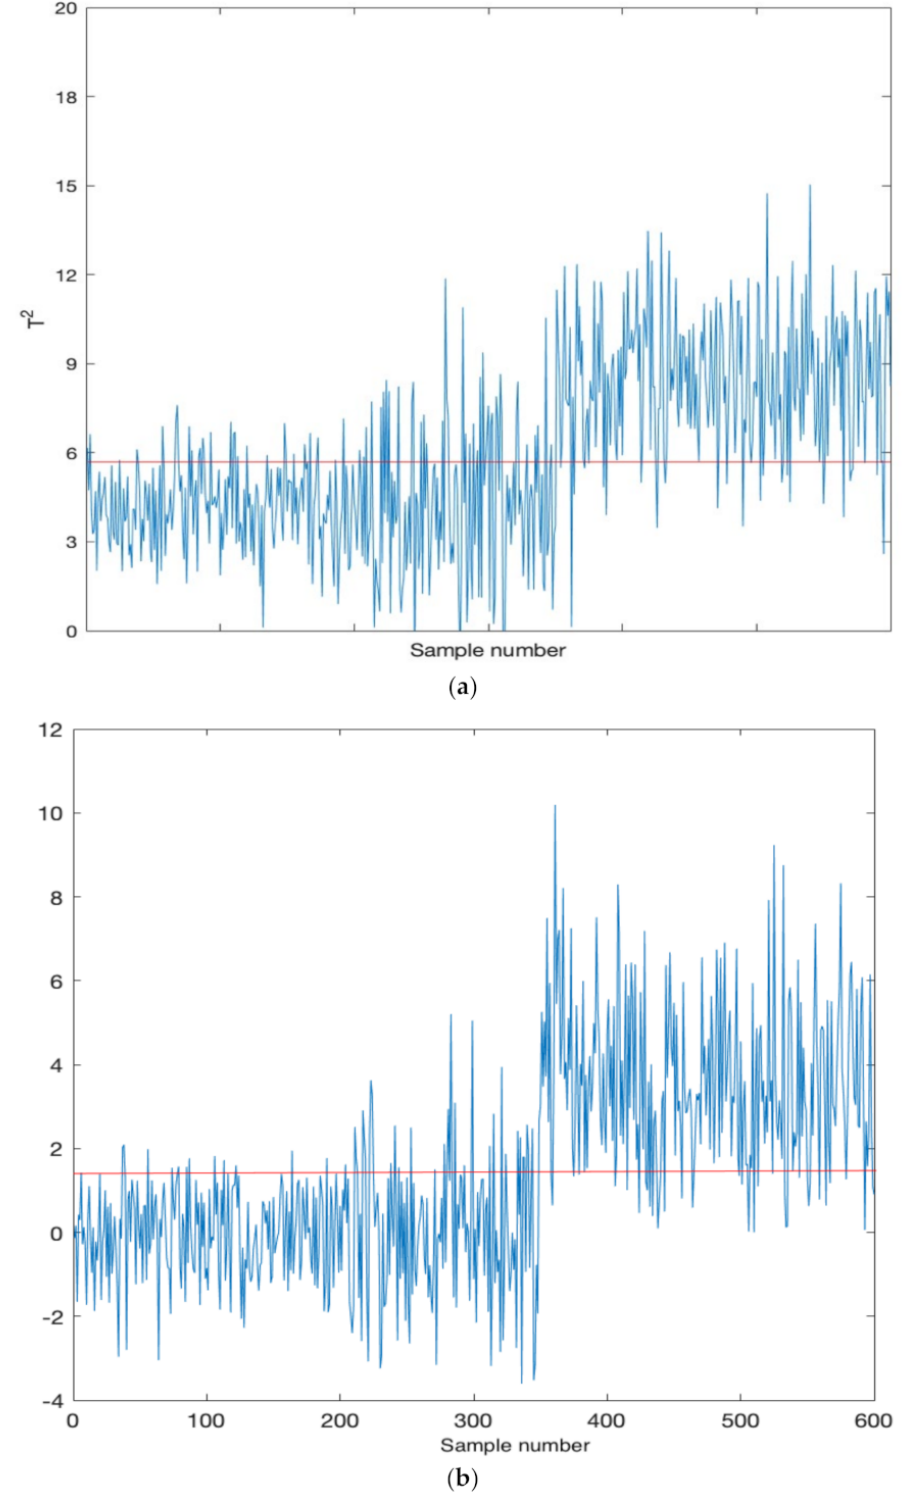
Figure 11. ( a ) KLPP-based T 2 chart fault detection results in quality pertinent; ( b ) KLPP-based Q chart fault detection results in quality